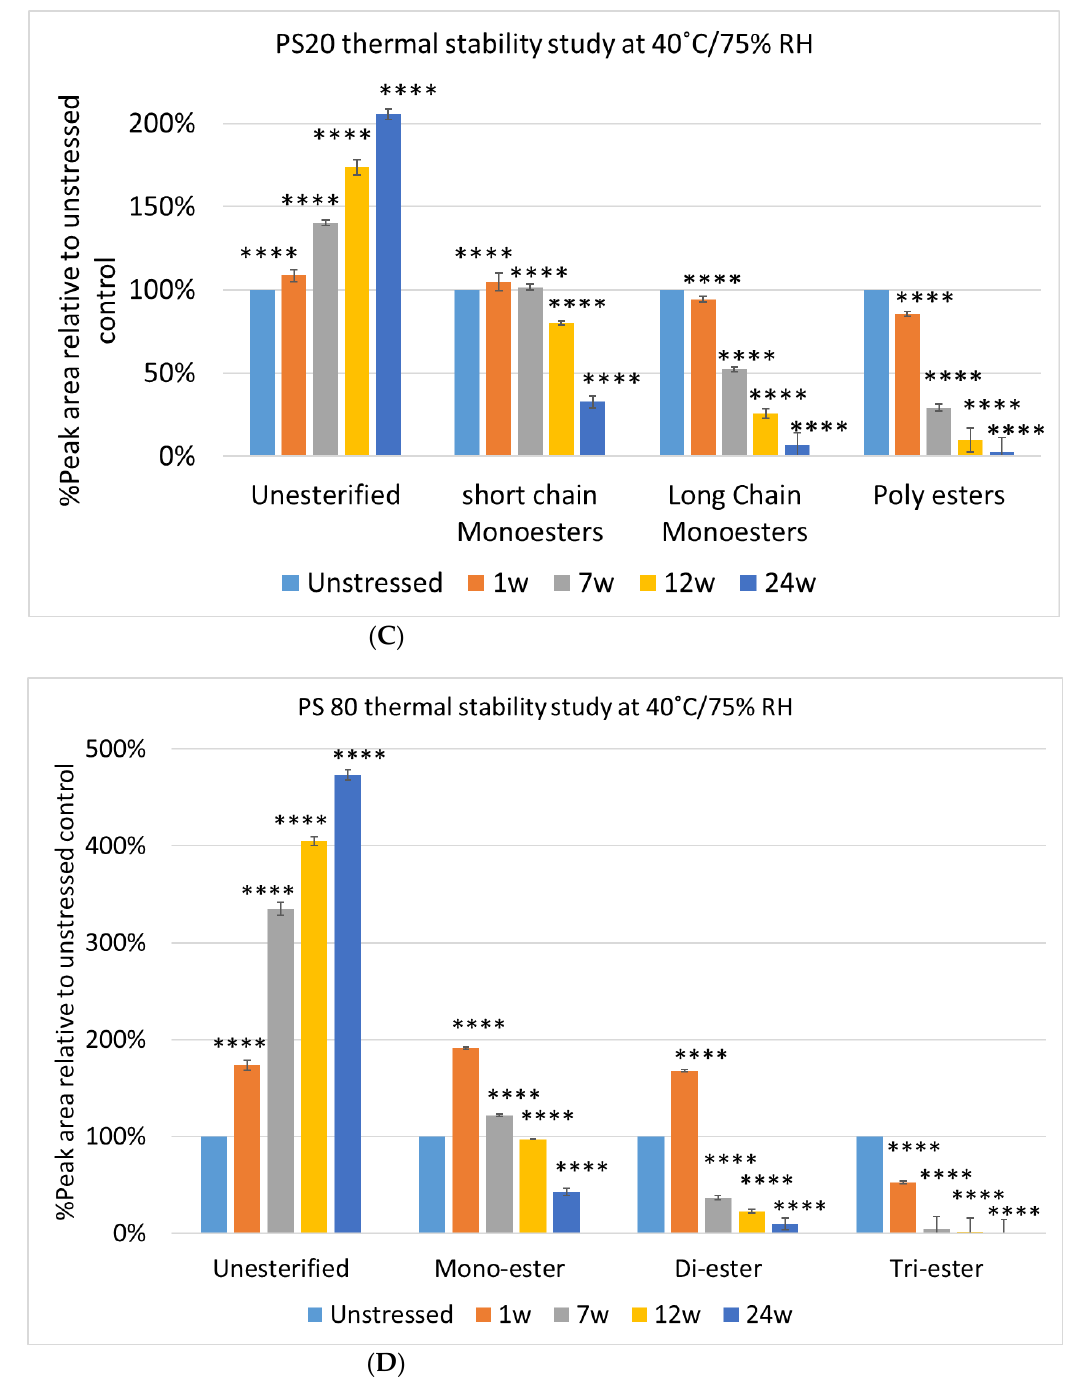
Figure 4. Thermal stability study of PS 20 and PS 80 at 40 °C / 75% RH: overlay chromatogram of PS 20 ( A ) and PS 80 ( B ) over time; the degradation of POE sorbitan esters in PS 20 ( C ) and in PS 80 ( D ) over time. * p < 0.05, ** p < 0.01, *** p < 0.001, and **** p < 0.0001.